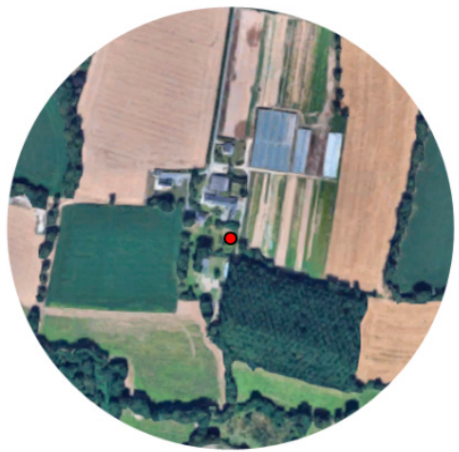
Figure 4. Characteristics of the rural environment of Rennes where the temperature sensor was installed (red dot).